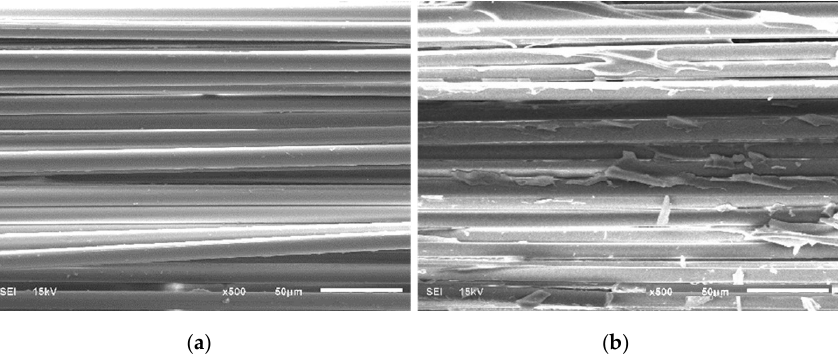
Figure 5. SEM micrographs ( a ) glass fiber morphology, ( b ) fractured surface of 80 wt% GF-rein- forced poly(BA-a)